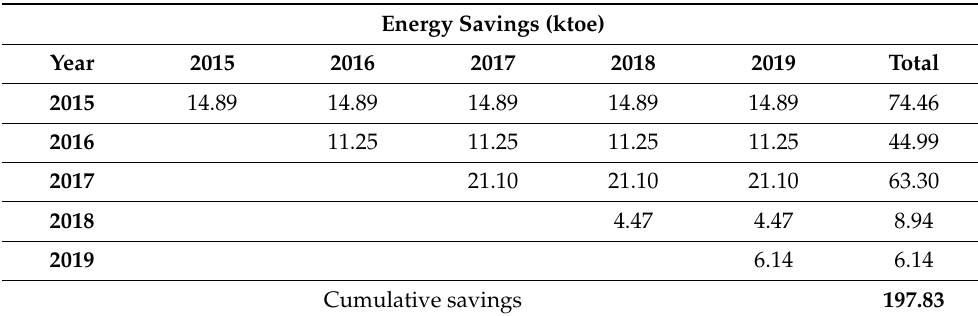
Table 4. Final energy savings (ktoe) for the years 2015–2019 associated with the information and training program carried out by the National Energy Efficiency